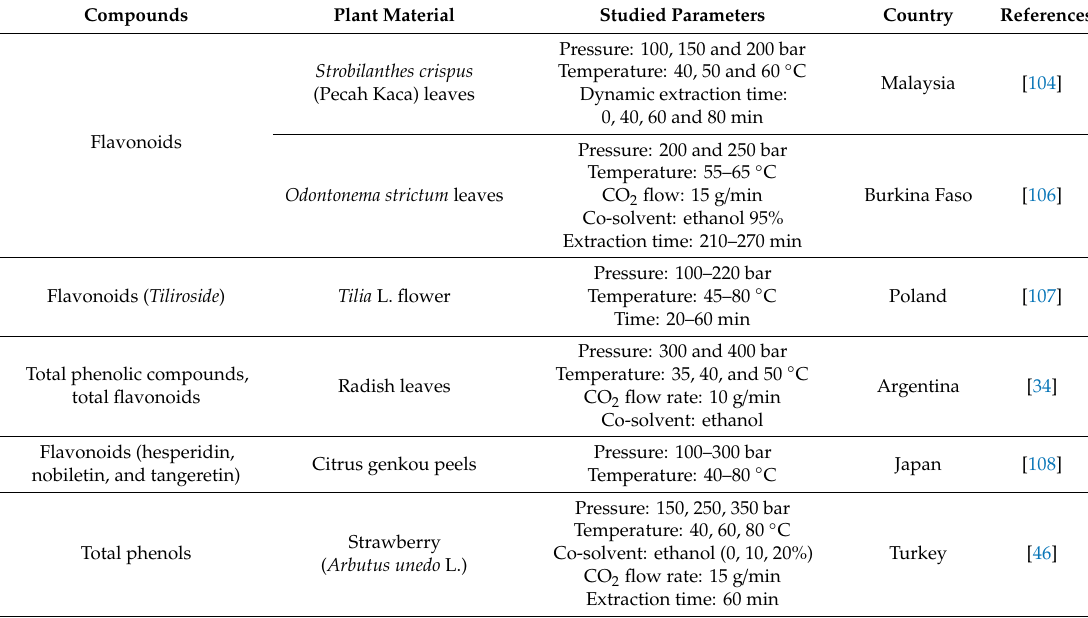
Table 6. Examples of phenolics extracted by supercritical CO